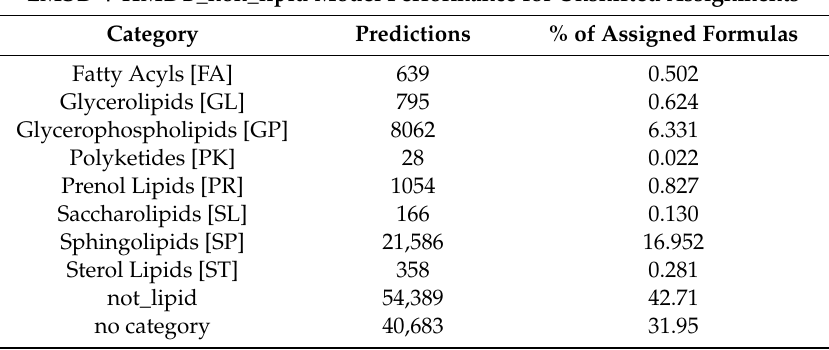
Table 5. LMSD + HMDB_non_lipid model performance for unshifted